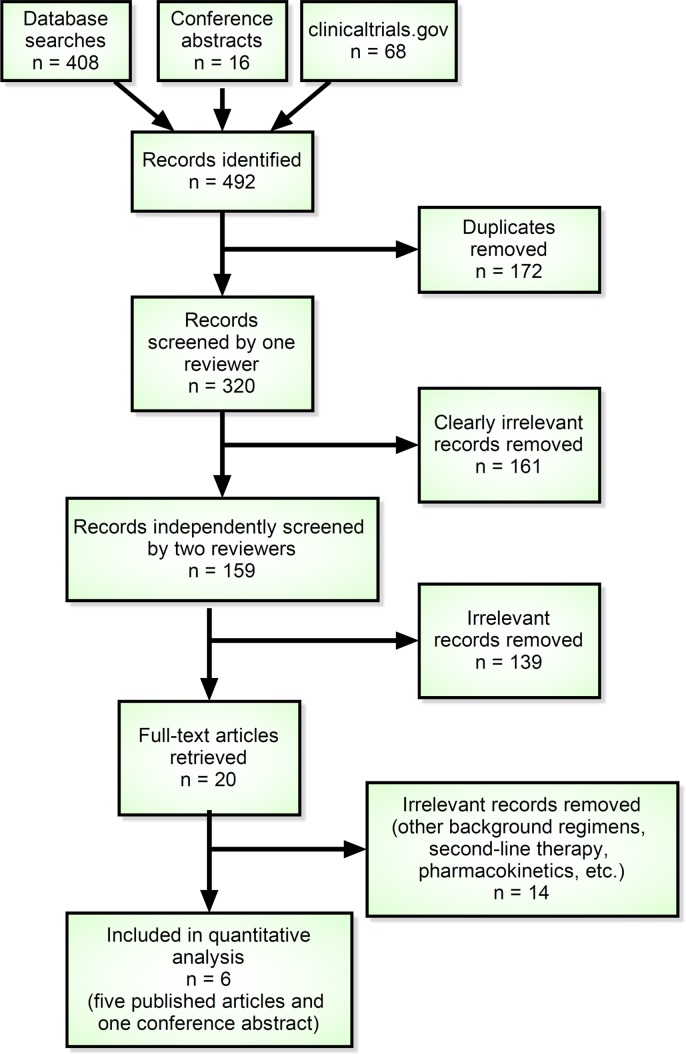
PRISMA flowchart: Flowchart depicting our screening process.